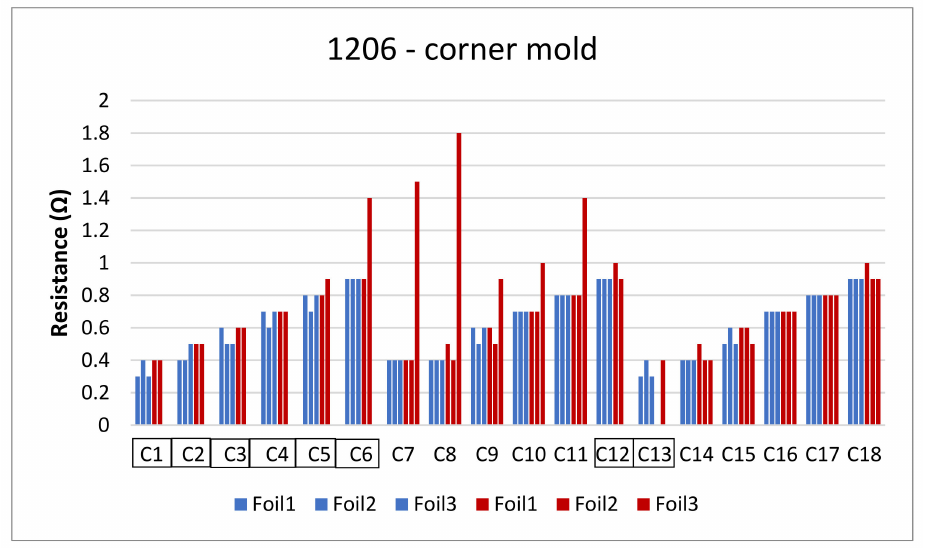
Figure 35. Resistance measurements for the corner mold.